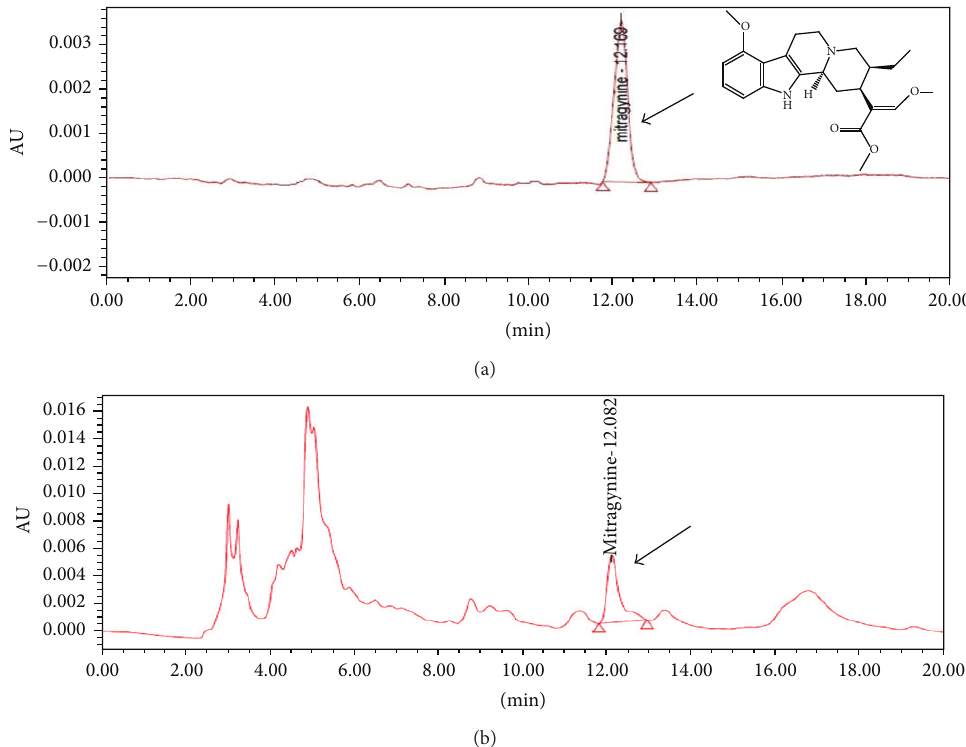
Figure 4: (a) HPLC chromatogram for the mitragynine standard and (b) chromatogram for the sample.